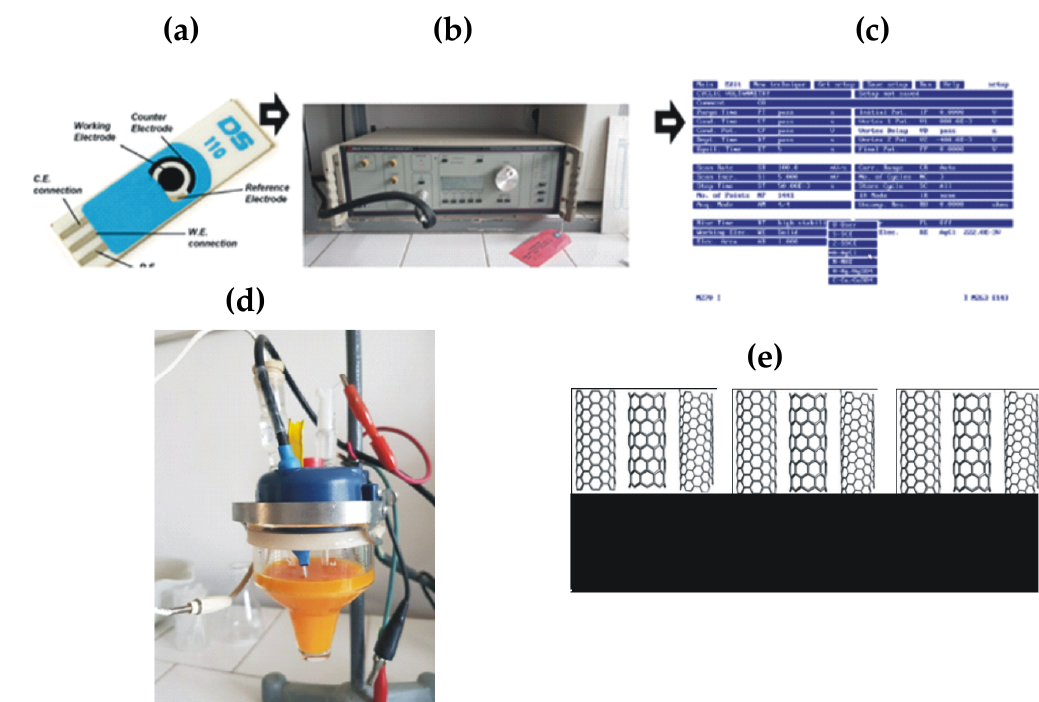
Figure 1. ( a ) Image of screen-printed carbon electrode; ( b ) Image of potentiostatgalvanostat EG&G (PrincetonAppliedResearch); ( c )ImageofECHEMsoftware; ( d )Imageofelectrochemicalcellcontaining GinkoPrim Max solution; ( e ) Schematic representation of the screen-printed carbon electrode modified with carbon nanotubes; ( f ) SEM image of the sensitive element of the CNT modified